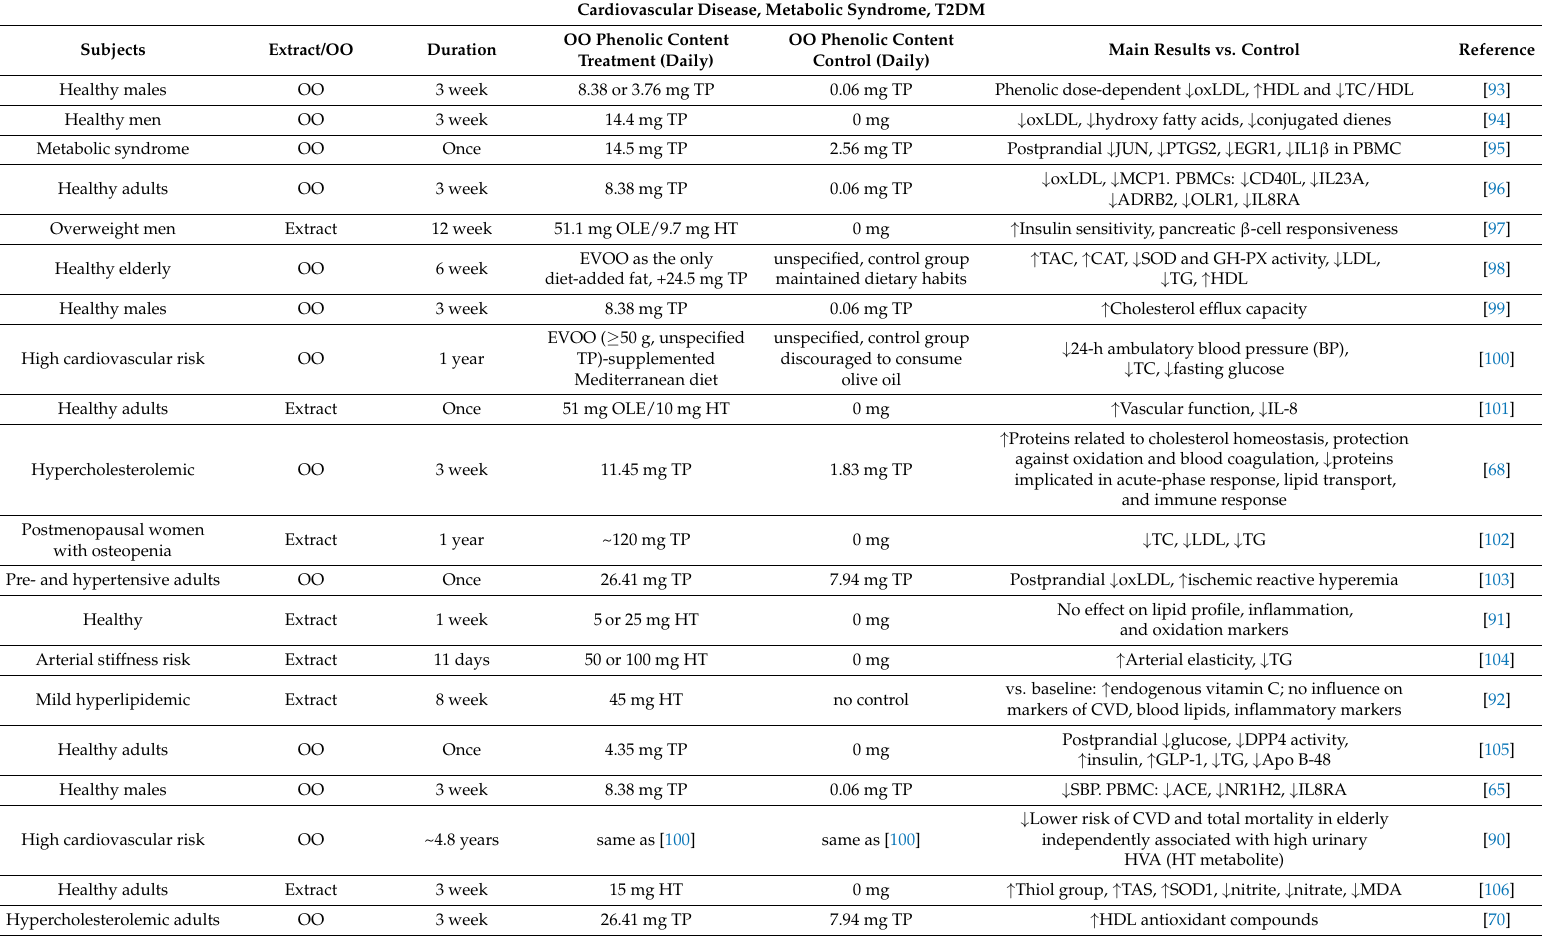
Table 1. Randomized clinical trials-based evidence on the effects and mechanisms after the consumption (acute or sustained) of phenol-rich olive oil and olive oil phenolic